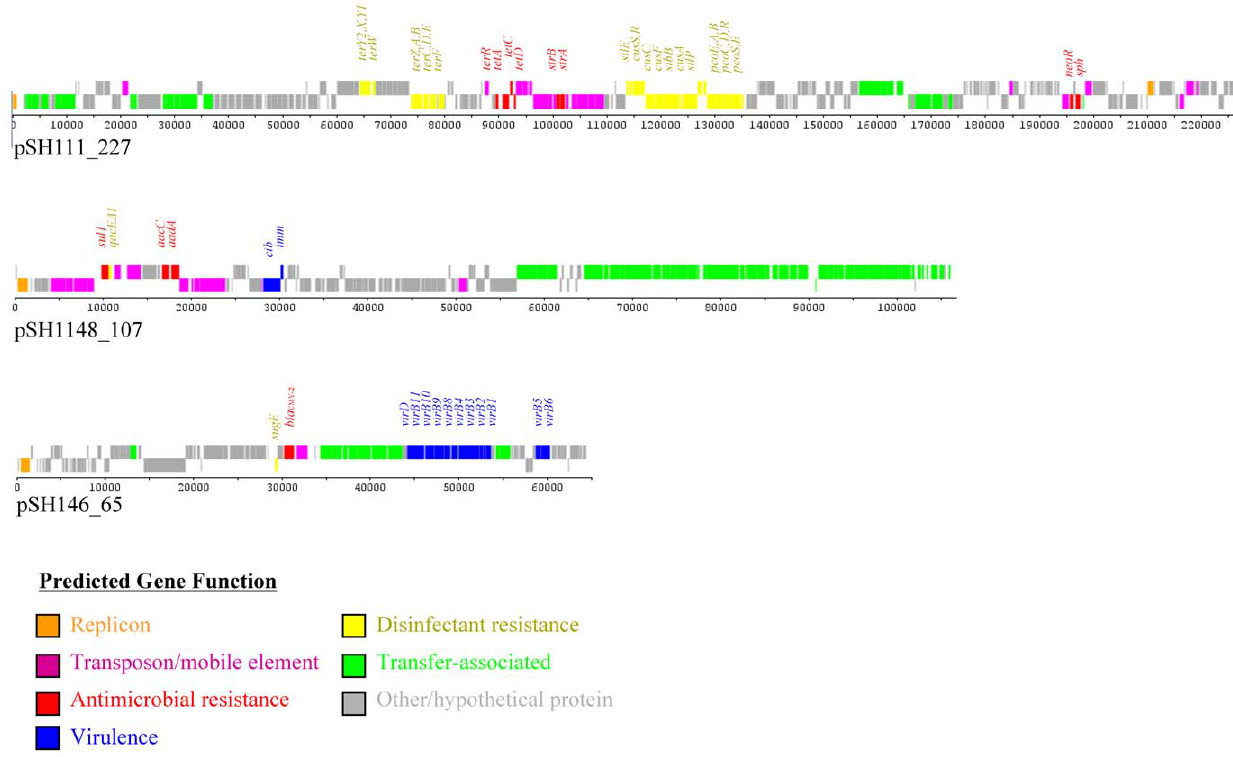
Figure 3. Linear representation of the other antimicrobial resistance plasmids sequenced in the study, including the IncHI2 plasmid pSH11_227, the IncI1 plasmid pSH1148_107 and pSH146_65, which was not classified by the Inc grouping. The predicted functions of genes are identified by the colors as indicated in the figure key and the predicted virulence, antimicrobial and disinfectant/heavy metal resistance genes are identified in each of the plasmids. doi:10.1371/journal.pone.0051160.g003 PLOS ONE |